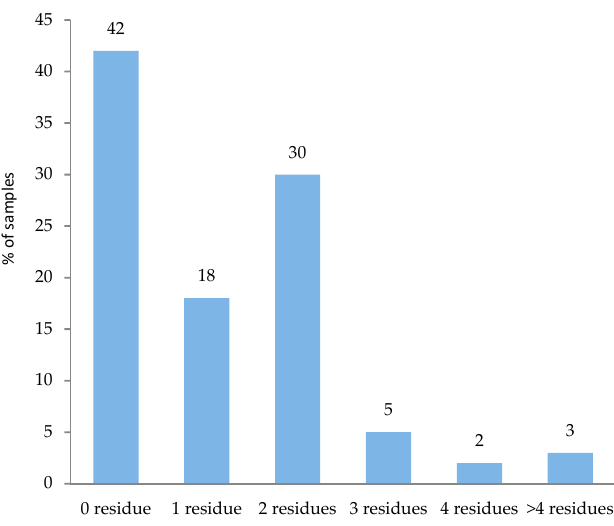
Figure 2. Fruit and vegetable samples with multiple residue of pesticides.